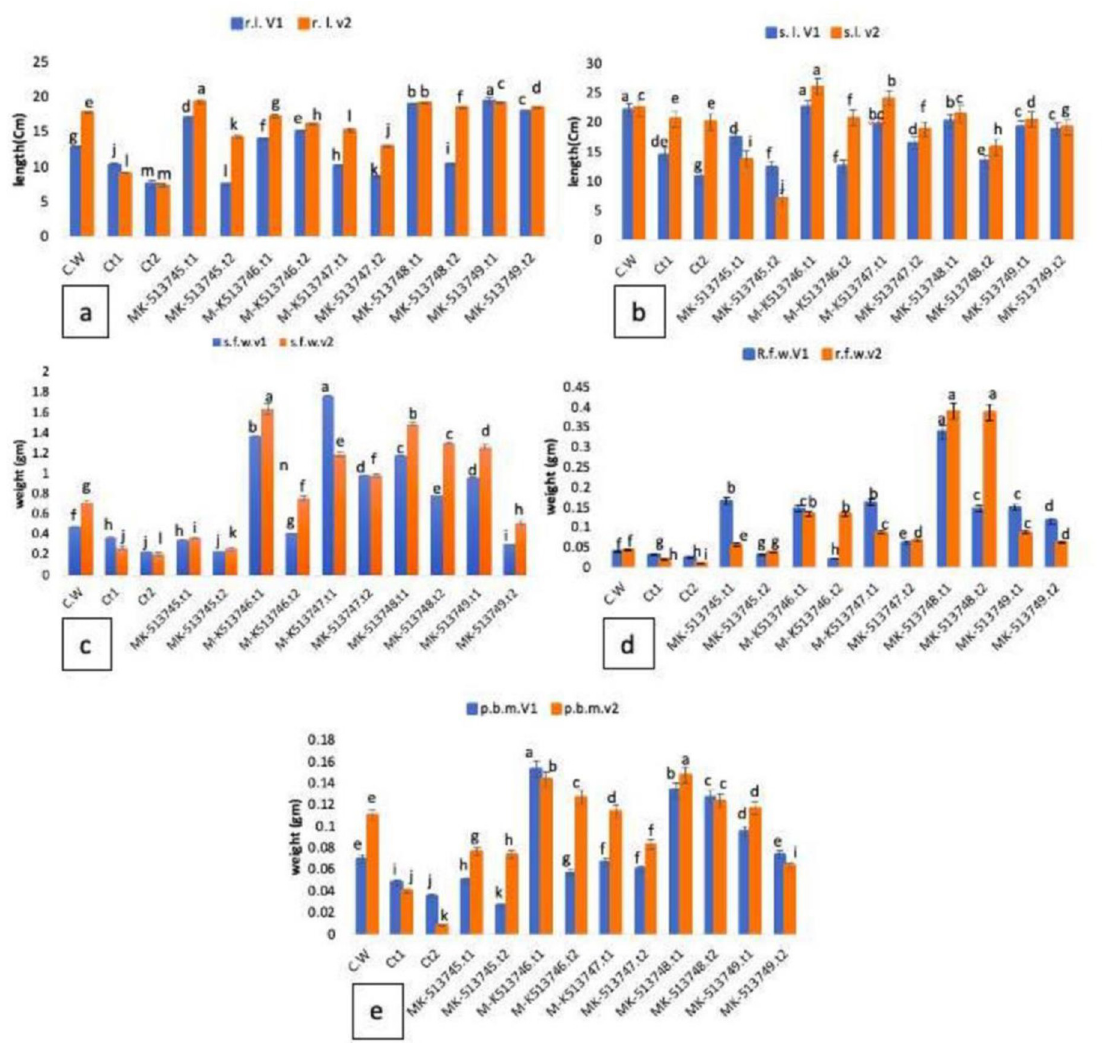
Fig 2. Effect of PGPR on the root length (a); shoot length (b); root fresh weight (c); shoot fresh weight (d) and plant dry biomass (e) of two different varieties of Vigna radiata grown under different drought conditions in lab trials. (t1 = 10% PEG and t2 = 20% PEG). The figure indicated traits varied significantly as a function of varieties (P < 0.05), PEG (P < 0.01) and strains (P <